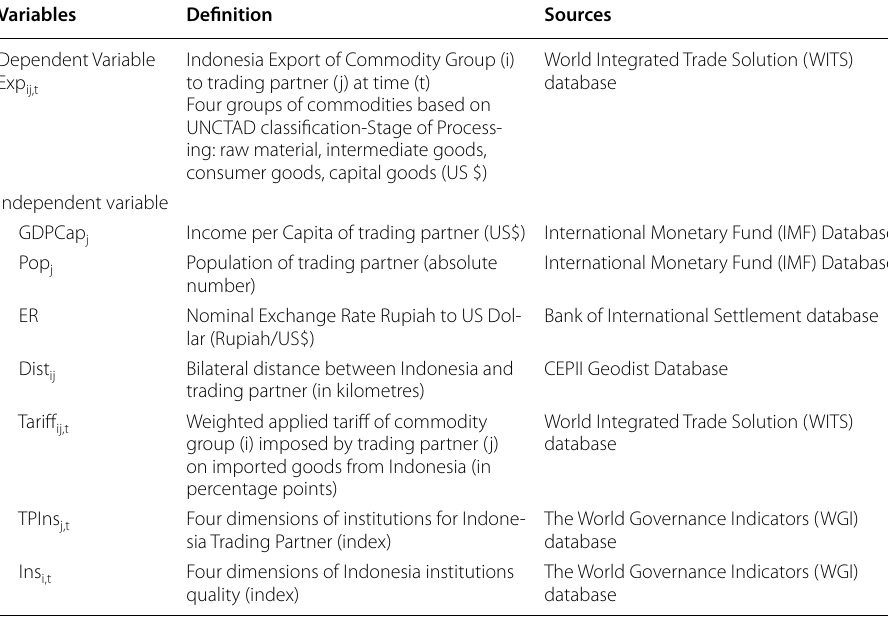
Table 3 Definition and data sources of variables